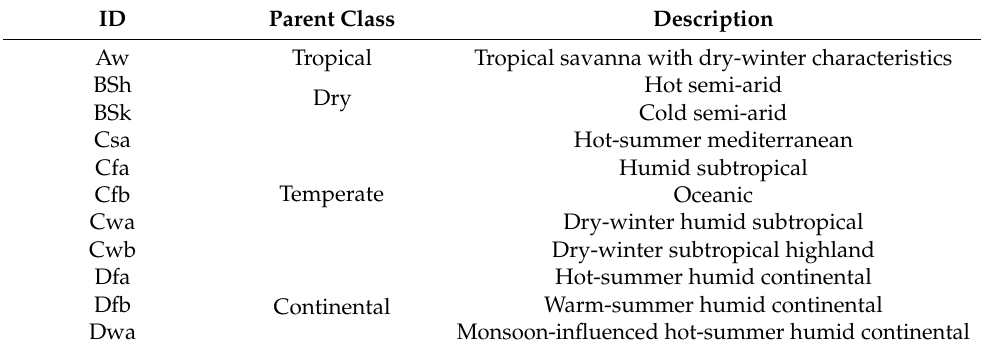
Table 2. The Köppen–Geiger climate classes analyzed in this